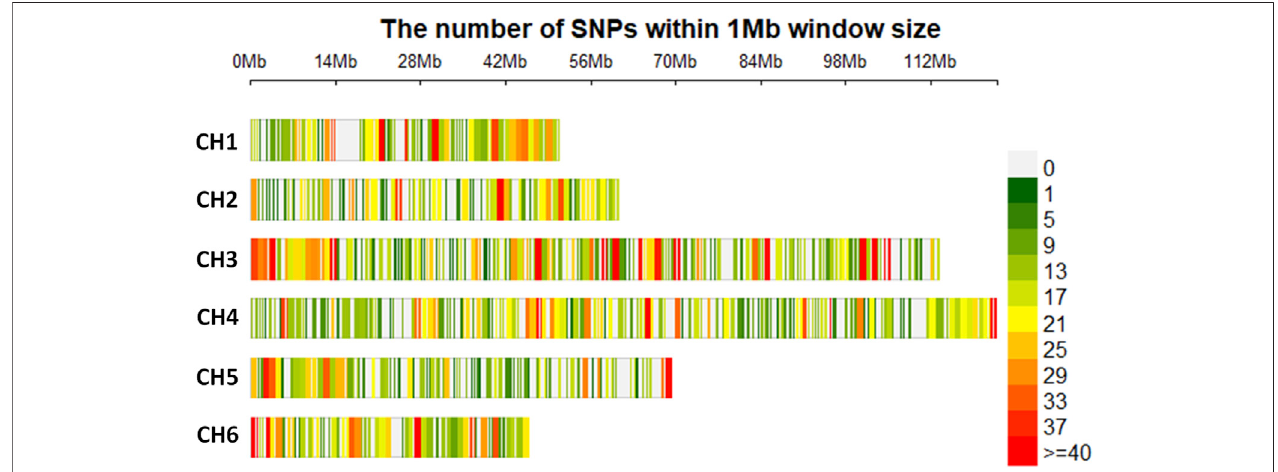
FIGURE 1 | Single nucleotide polymorphisms (SNPs) detected in Spinacia genomes after quality fi ltration, showing the physical density map of 7,065 SNPs common to 16 S. oleracea and 76 S. turkestanica accessions. The colors refer to the SNP density across the six chromosomes (CH1 to CH6) in the Spinacia genome. Numbers above the six chromosome diagrams refer to the distance (in Mb) on the chromosomes of SNPs retained after fi